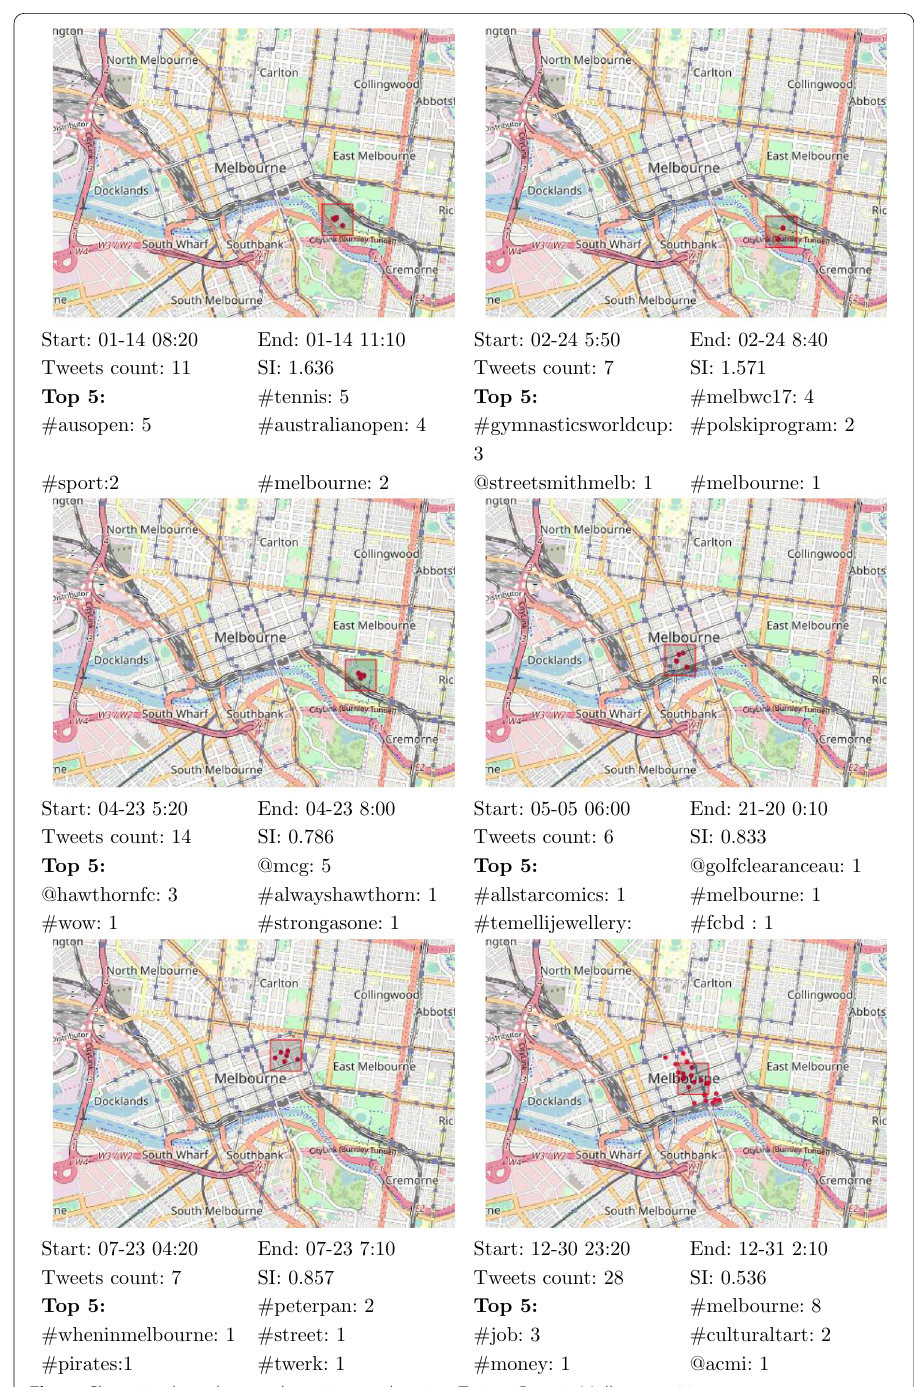
Fig. 5 Clustering based event detection results using Twitter Data in Melbourne,